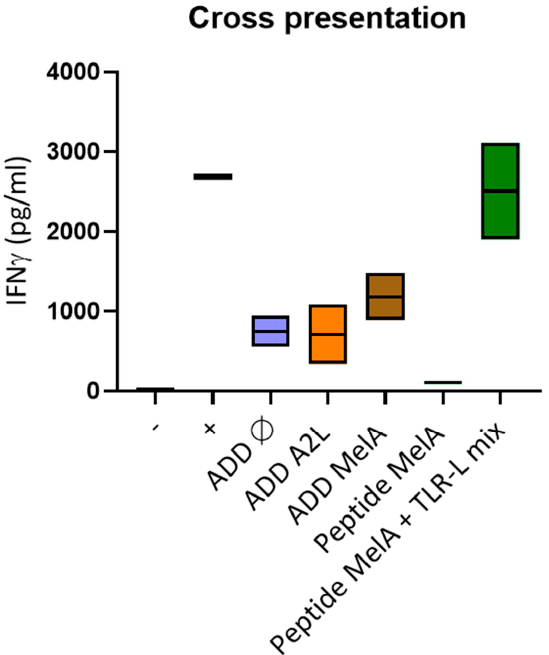
Figure 4. DCs efficiently cross-present the A2L epitope from ADDomer displaying MelA. Puri- fied panDCs were incubated with ADD Ø, ADD A2L, ADD MelA, Peptide MelA and Peptide